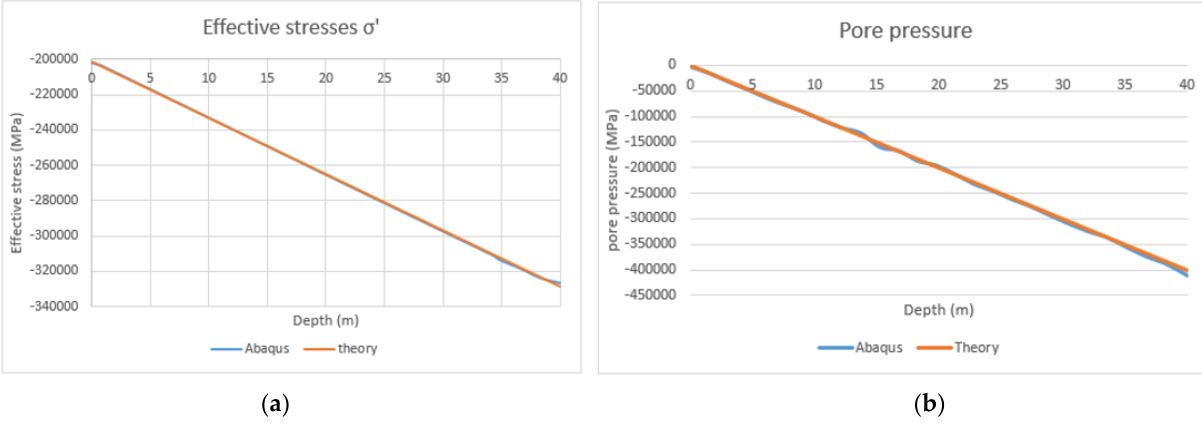
Figure 11. Stresses in situ: ( a ) Effective stresses ( σ’ ), ( b ) Pore pressure.